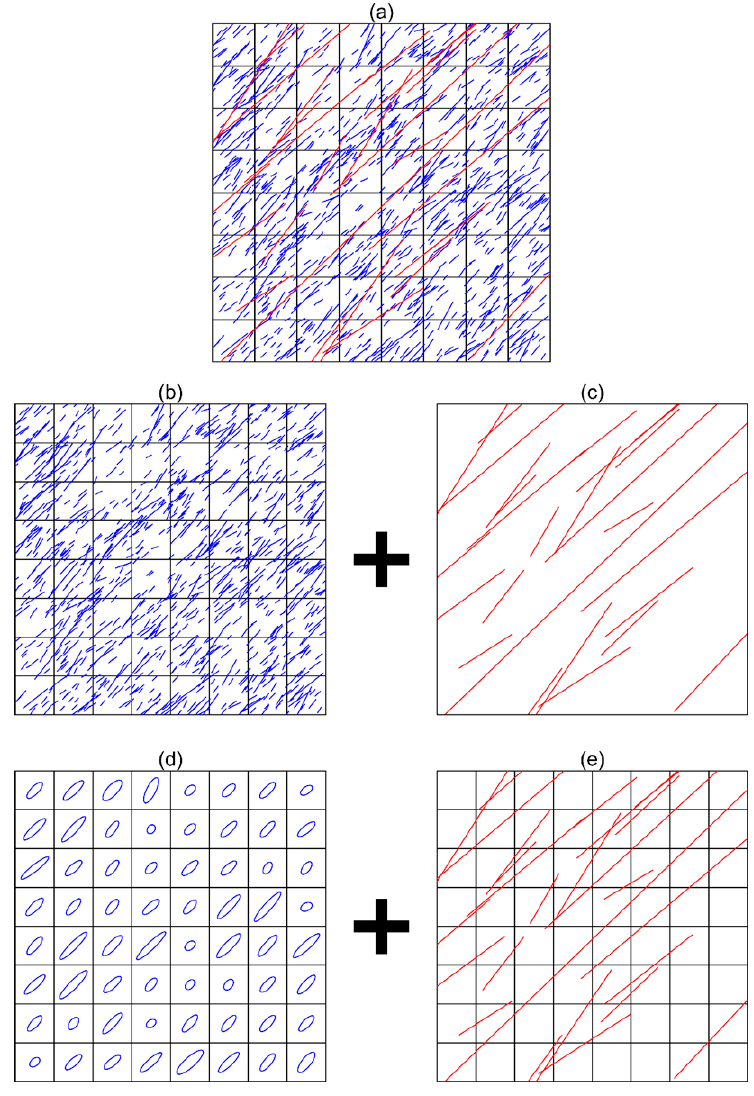
Figure 1. Workflow for modeling fractures with multiple length scales.